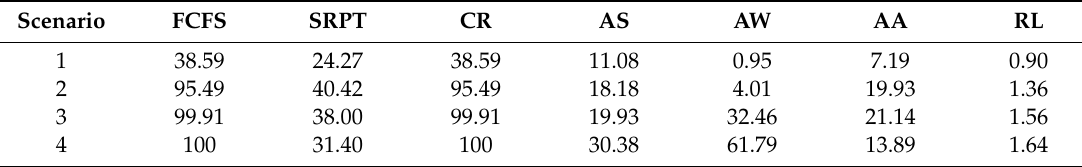
Table 6. Number of penalty patients